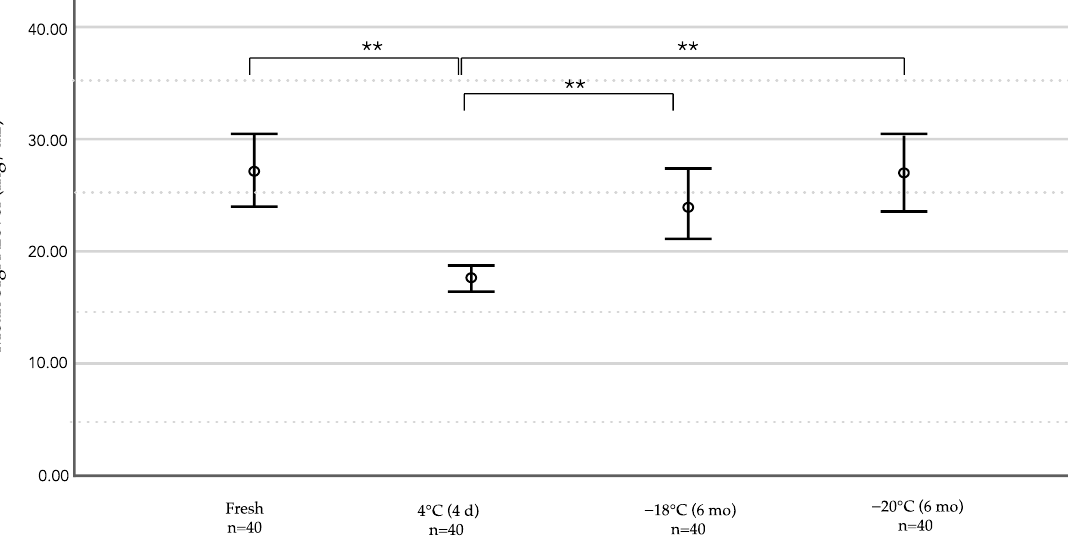
Figure 2. Comparison of SIgA concentrations between fresh, refrigerated (2 °C), frozen at −16.7 °C, and frozen at −22.3 °C HM samples. Data were analyzed using one-way analysis of variance (ANOVA) with Dunnett T3 pairwise comparisons for the SIgA concentration. ** p < 0.001. Table 3. SIgA and lysozyme activity levels detected in fresh HM and HM samples frozen at −18 and −20 °C.